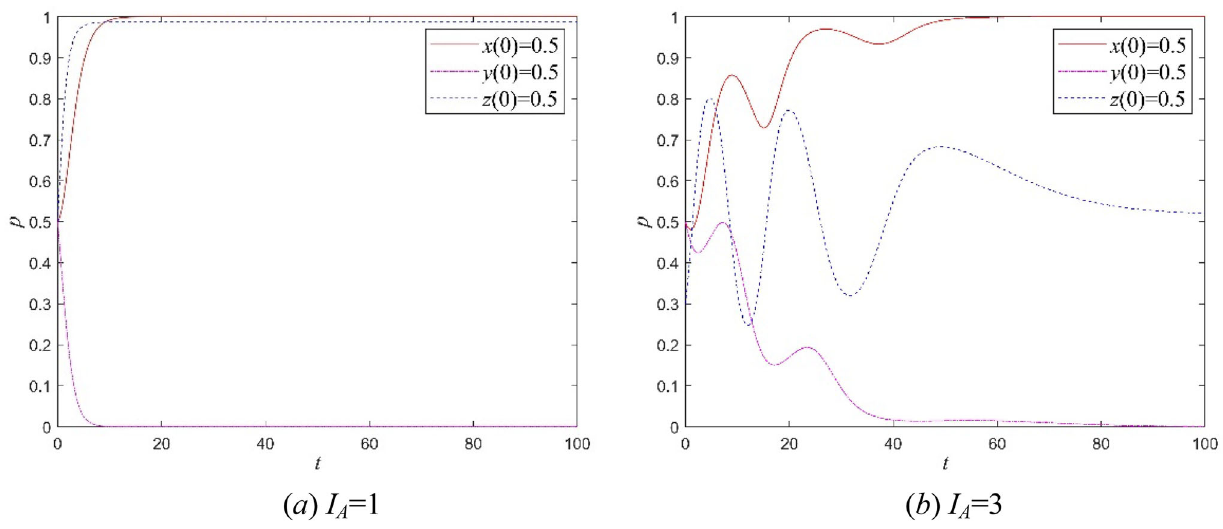
Fig. 9 ( a ) I A (cid:2) 1, ( b ) I A (cid:2)